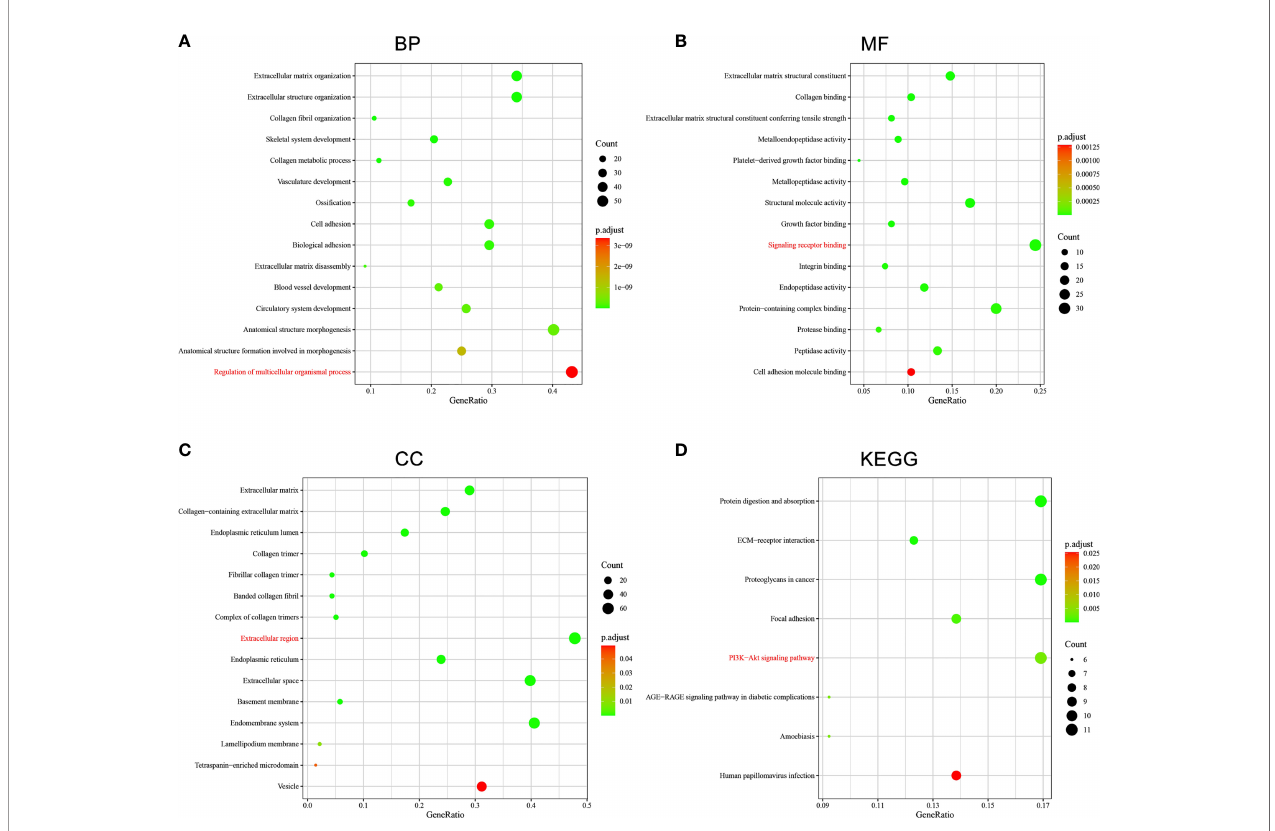
FIGURE 11 | Functional enrichment analysis of SERPINE1-related genes in STAD. (A) GO : BP. (B) GO : MF. (C) GO : CC. (D) KEGG. The terms in red were the mainly enriched GO terms and KEGG